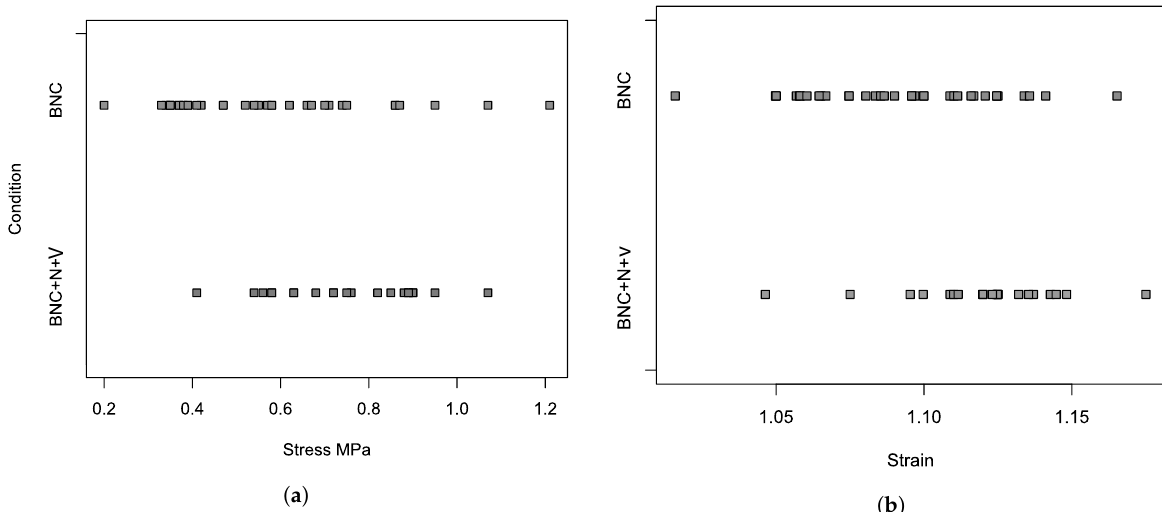
Figure 10. An illustration for analysis of variance. ( a ): the values of the ultimate stress for material with and without chitosan, ( b ): for the ultimate deformation. (Each point represents one